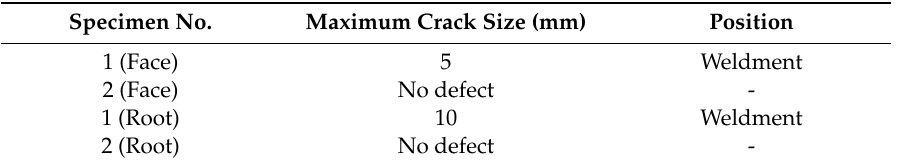
Table 8. Guided bend test